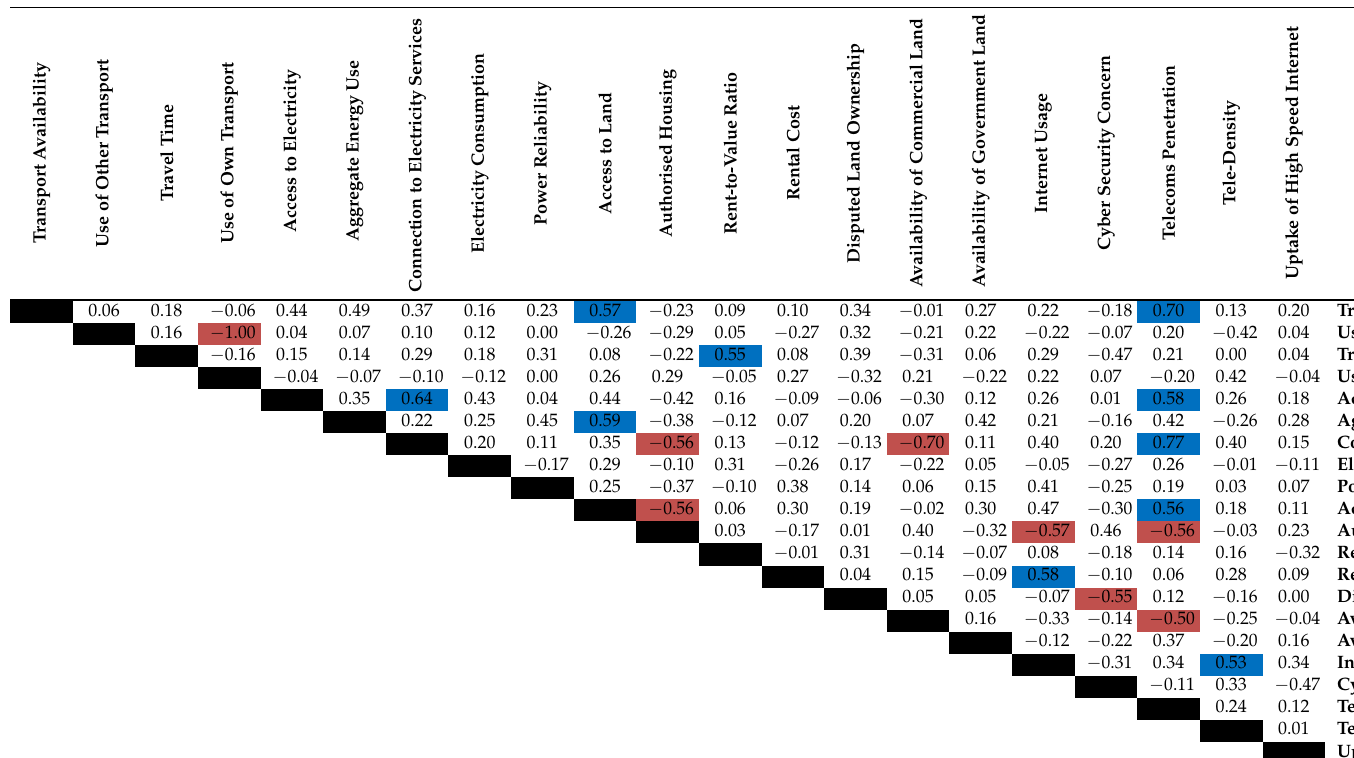
Table 6. Correlation Matrix of Preliminary